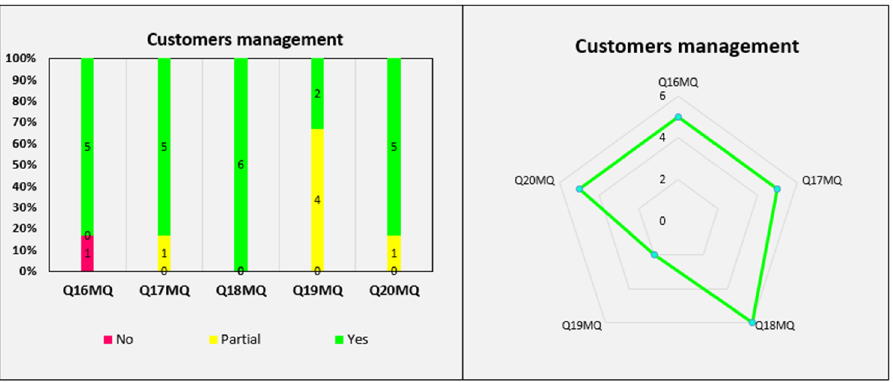
Figure 12. Answers regarding the customer management criteria.